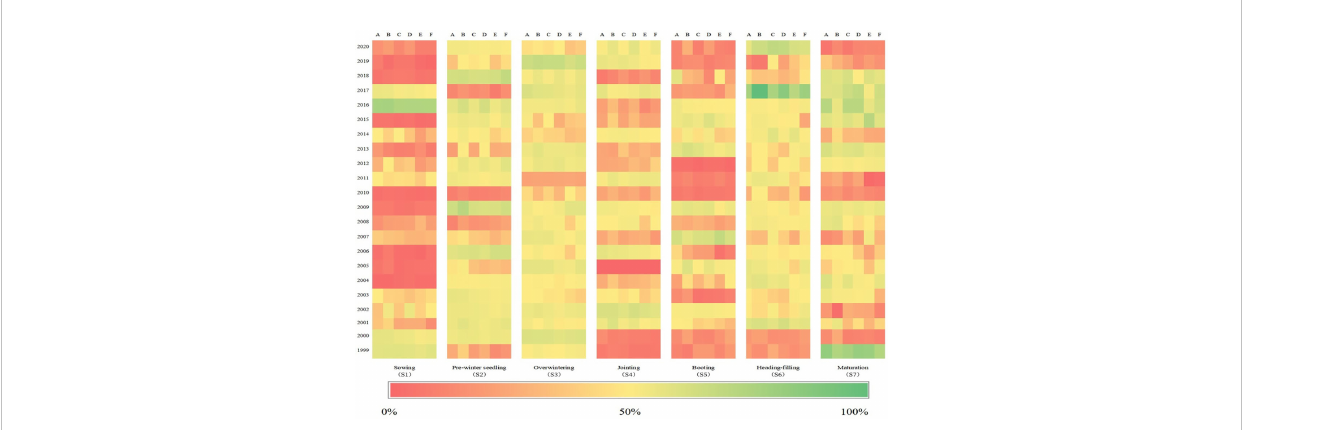
FIGURE 3 Precipitation during various wheat growth stages including Sowing (S1), Pre-winter seedling (S2), Overwintering (S3), Jointing (S4), Booting (S5), Head- fi lling (S6) and Maturation (S7) in ‘ Yanhuai ’ region i.e. (A) Yingshang, (B) Huoqiu, (C) Fengtai, (D) Shouxian, (E) Huaiyuan, and (F) Fengyang from 1999 to 2020. The greater greenness indicates more precipitation and wetter, while the greater redness indicates less precipitation and drier.